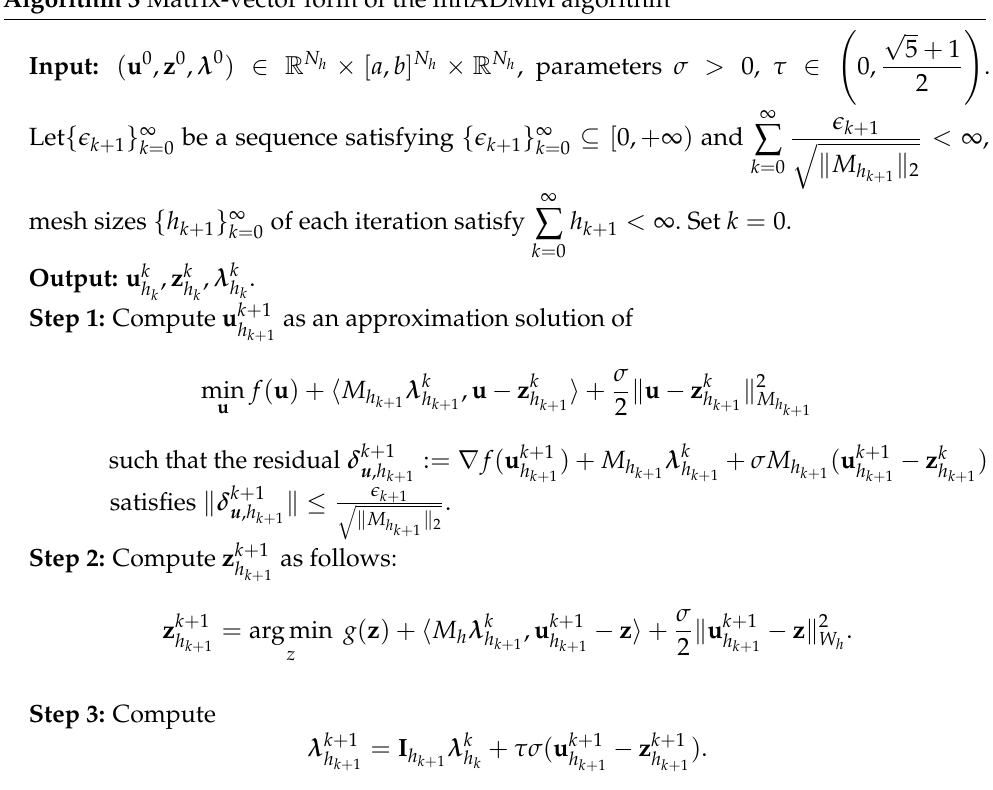
Algorithm 3 Matrix-vector form of the mhADMM